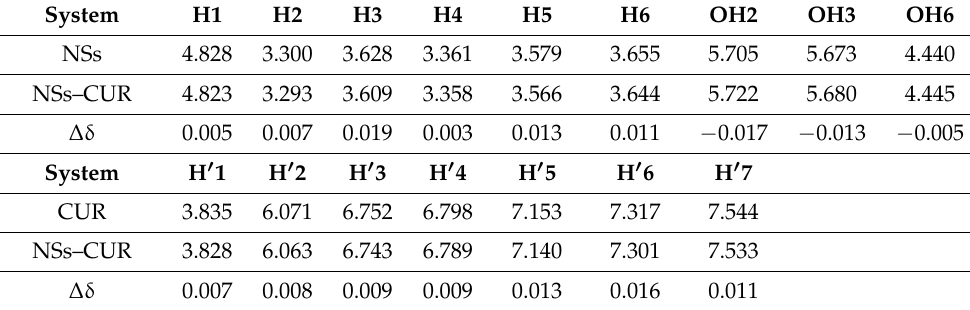
Table 2. Proton assignments and chemical shifts for NSs, CUR and